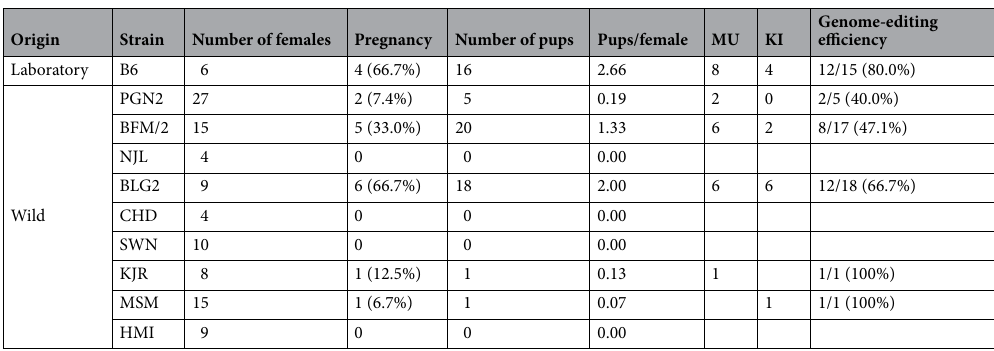
Table 3. Efficiencies of genome editing upon application of i -GONAD with 6 transfer pulses